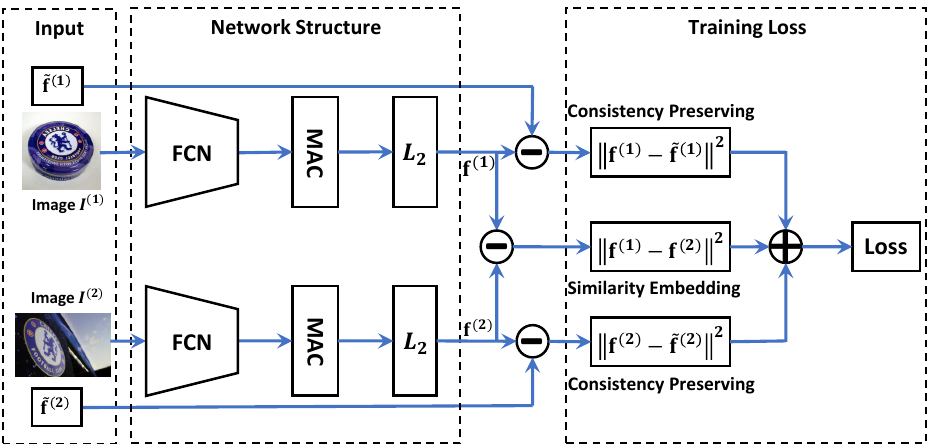
Figure 2. The network architecture of the proposed network. A pair of images are fed into two fully-convolutional networks (FCNs) separately to generate MAC representations. These two FCNs are identical in architecture and share parameters. The generated MACs and their corresponding pre-extracted MACs (with original network parameters) are then sent to calculate the loss. The loss consists of a similarity embedding part to embed manifold information into network parameters and a consistency preserving part to prevent dramatic modification of model